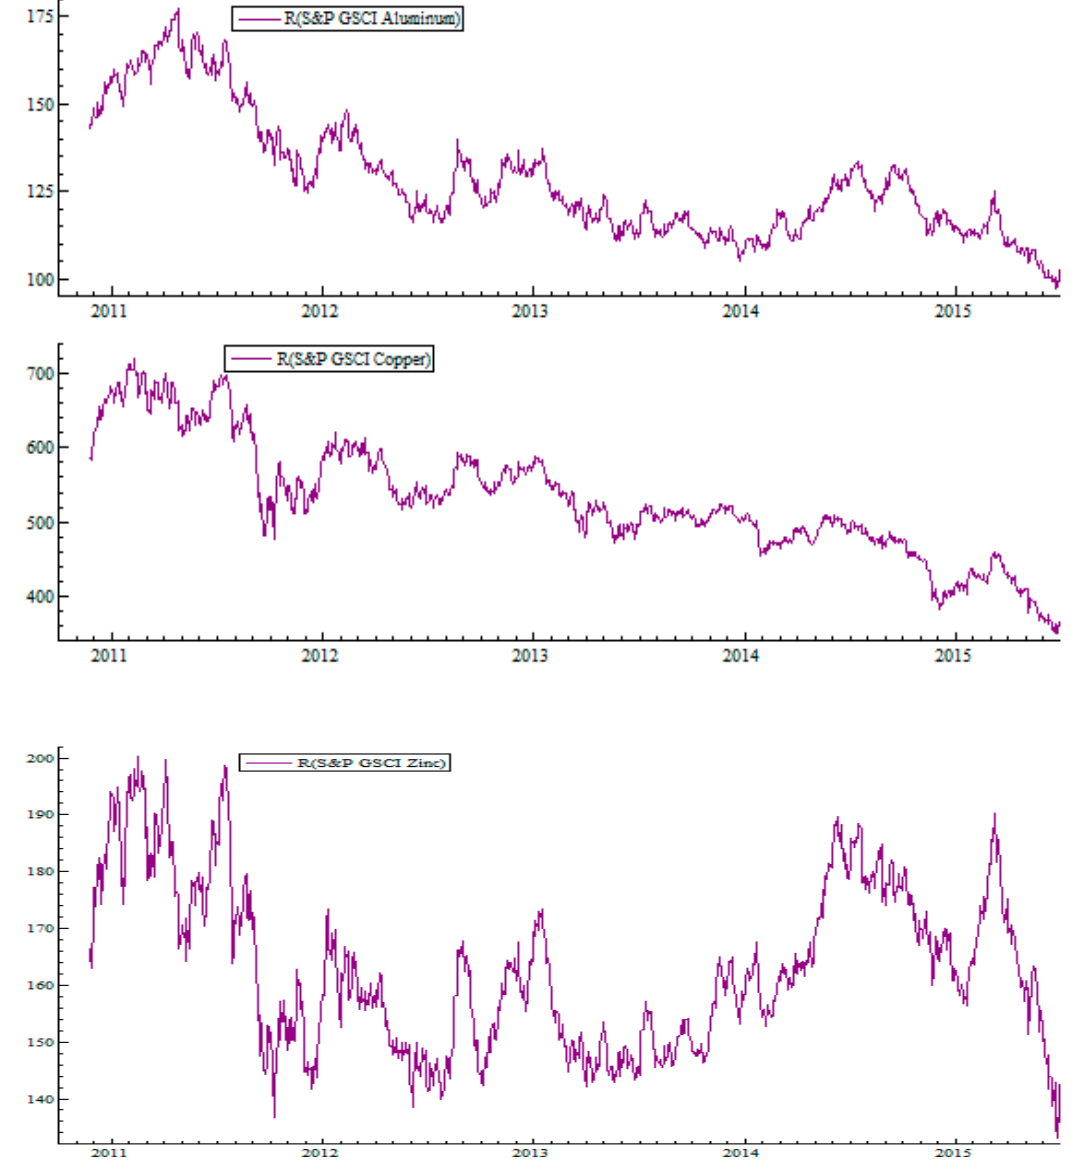
Figure 1. Price dynamics of commodity indices. Note : Blue lines represent energy indices; green lines, precious metals; red lines, soft commodities; and purple lines, industrial metals.